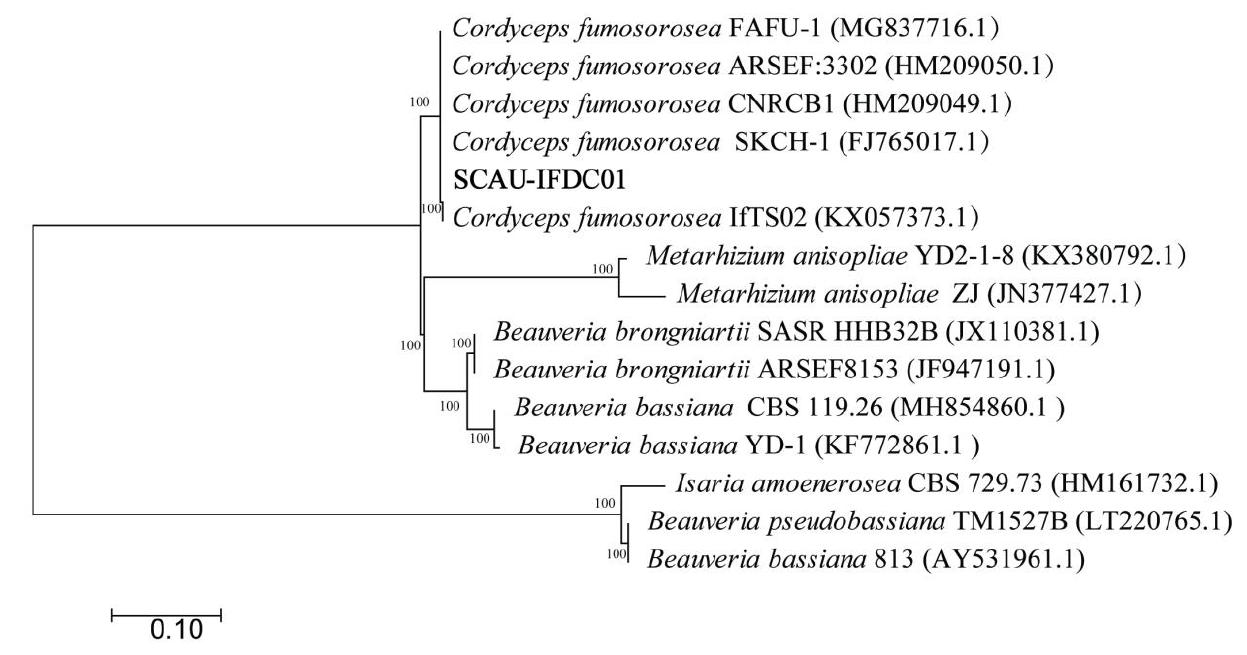
Figure 2. Molecular identification and phylogenetic analyses of the SCAU-IFDC01 fungus isolate from D. citri based on ITS1/ITS5 and maximum likelihood method.